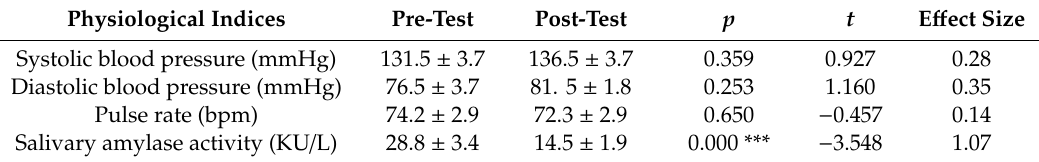
Table 3. E ff ect of Kokedama on physiological indices.